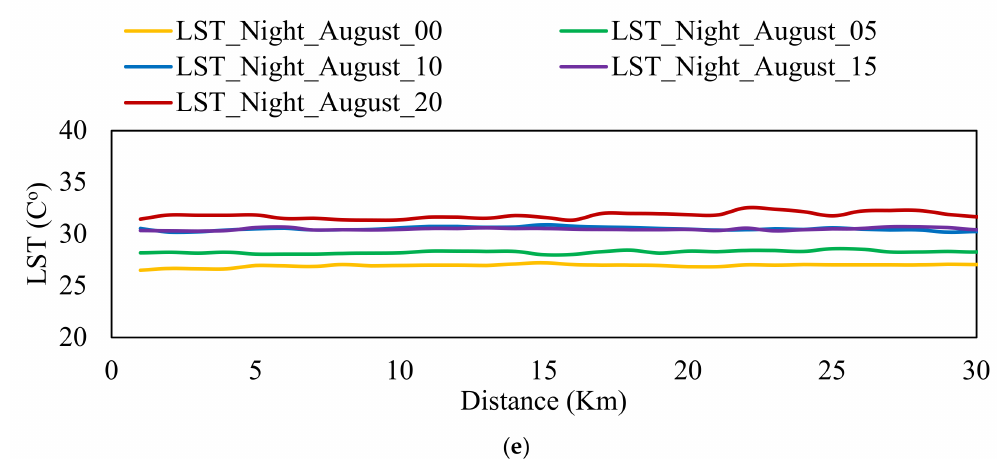
Figure 20. Temporal Profiling of Nighttime LST in Summer Seasons. ( a ) Profile 1; ( b ) Profile 2; ( c ) Profile 3; ( d ) Profile 4; ( e ) Profile 5.